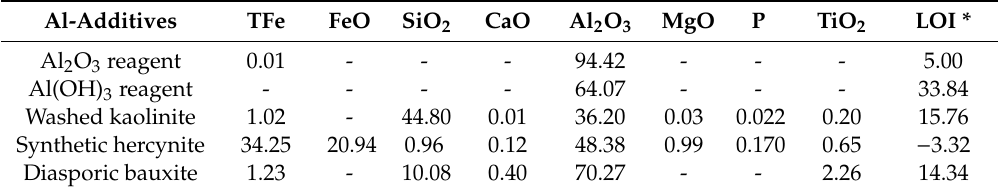
Table 3. Chemical compositions of Al-additives (wt%).